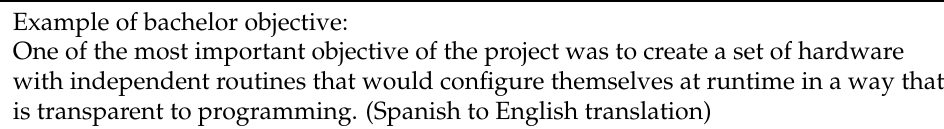
Table 5. Segmentation example for B-Q1 and I-Q1.